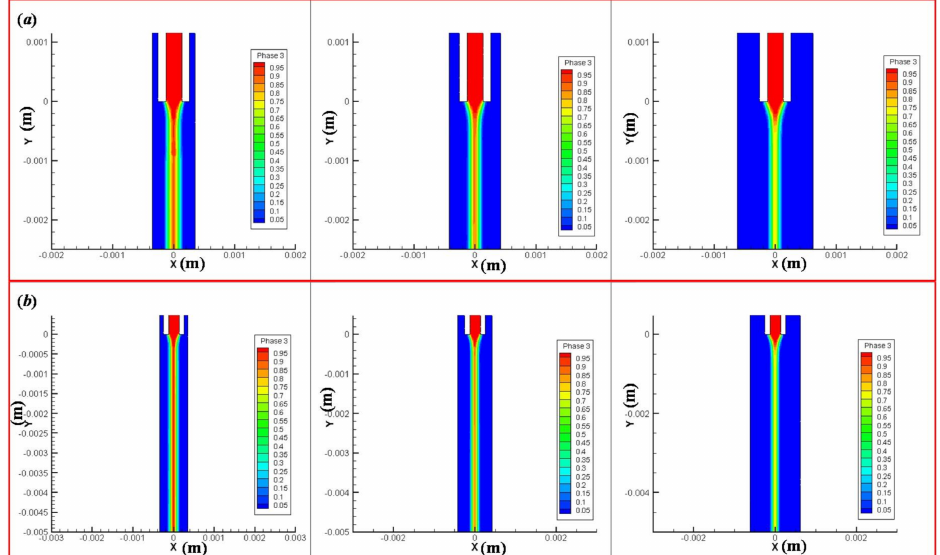
Figure 5. The influence of lead length and outer cavity diameter on the diameter of extruded material. ( a ) When the lead length is 2.5 mm, the change of extrusion material diameter under the outer cavity diameter 0.7, 0.84 and 1.25 mm. ( b ) When the lead length is 5 mm, the change of extrusion material diameter under the outer cavity diameter 0.7, 0.84, and 1.25